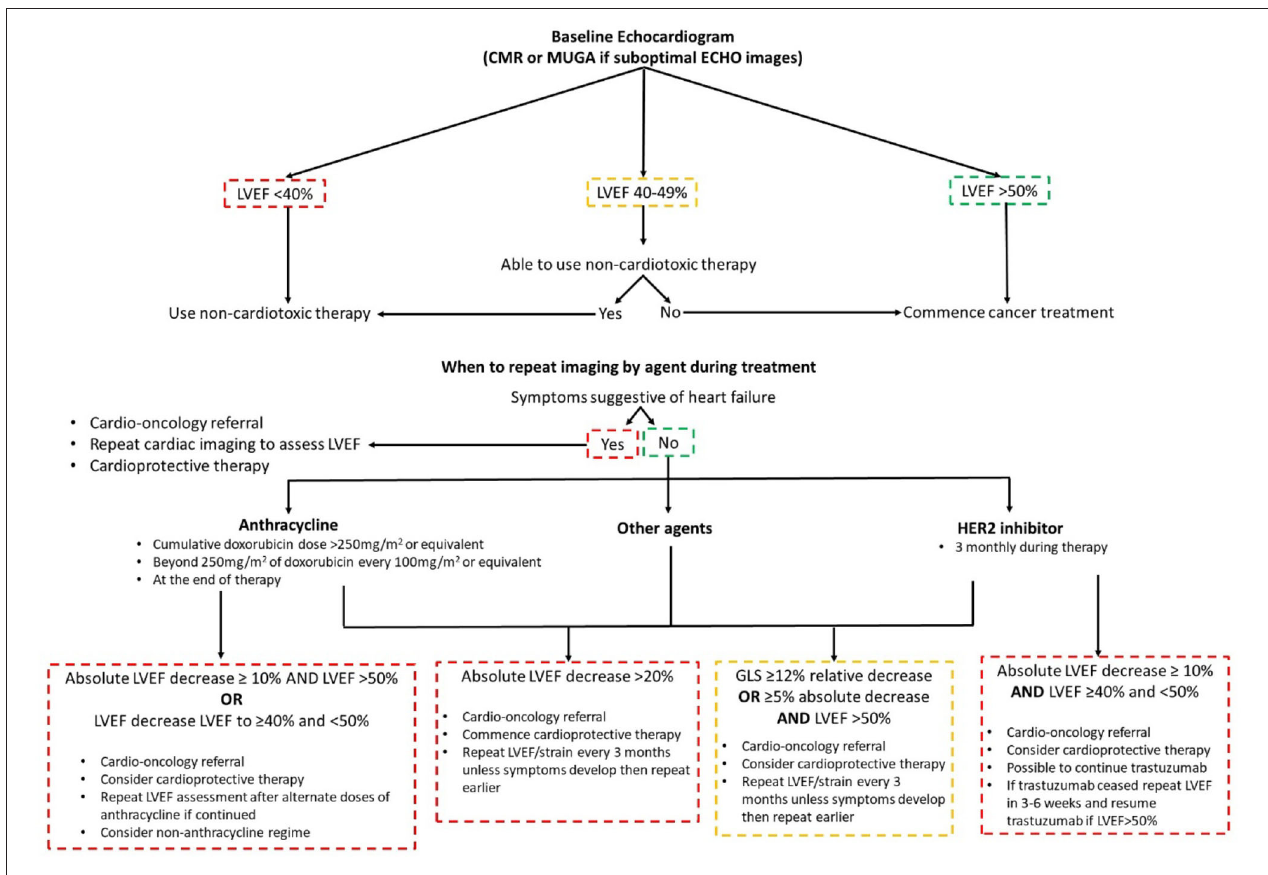
FIGURE 2 | Summary of the ESMO 2020 cardiac imaging guidelines.